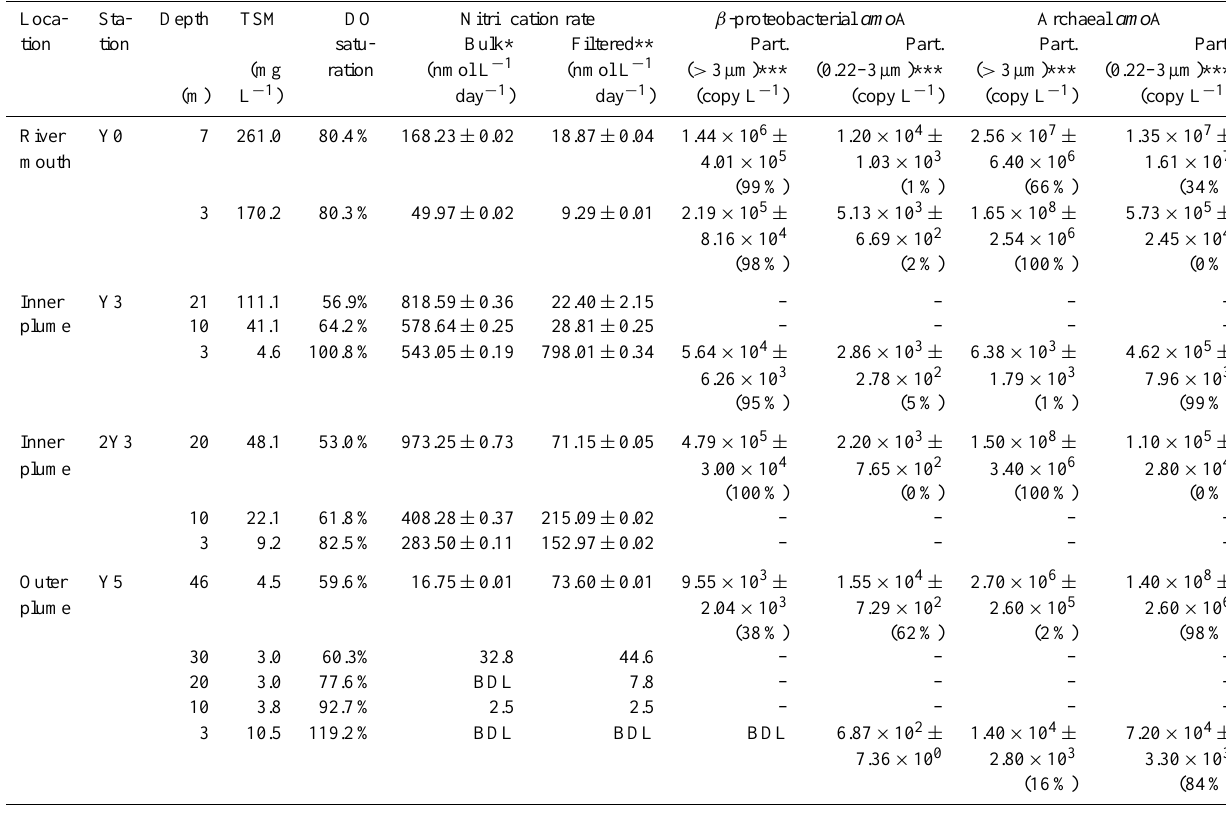
Table 1. Particulate-associated archaeal and β -proteobacterial amo A copies and the nitrification rate in bulk versus filtered water for three stations along the Chang Jiang River